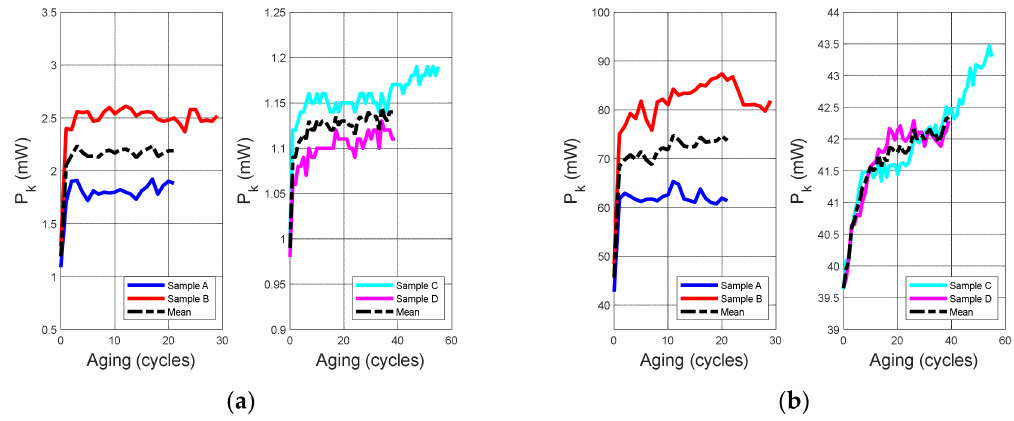
Figure 9. Dielectric loss (P k ) measurement results for 50 Hz ( a ) 2 kV and ( b ) 12